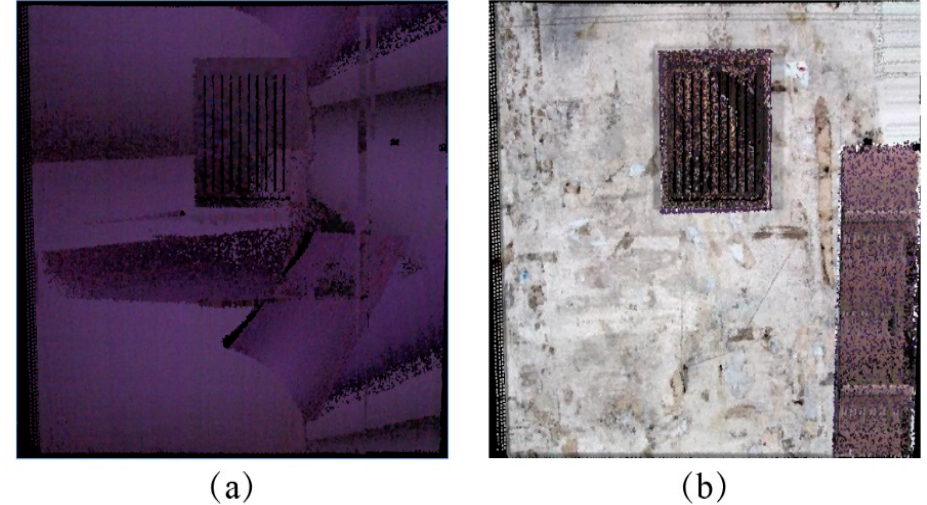
Figure 12. Point cloud of a wall with a window and door of the Zou Lu House: ( a ) the original registered point cloud; ( b ) registered point cloud after the proposed colorization method is applied.